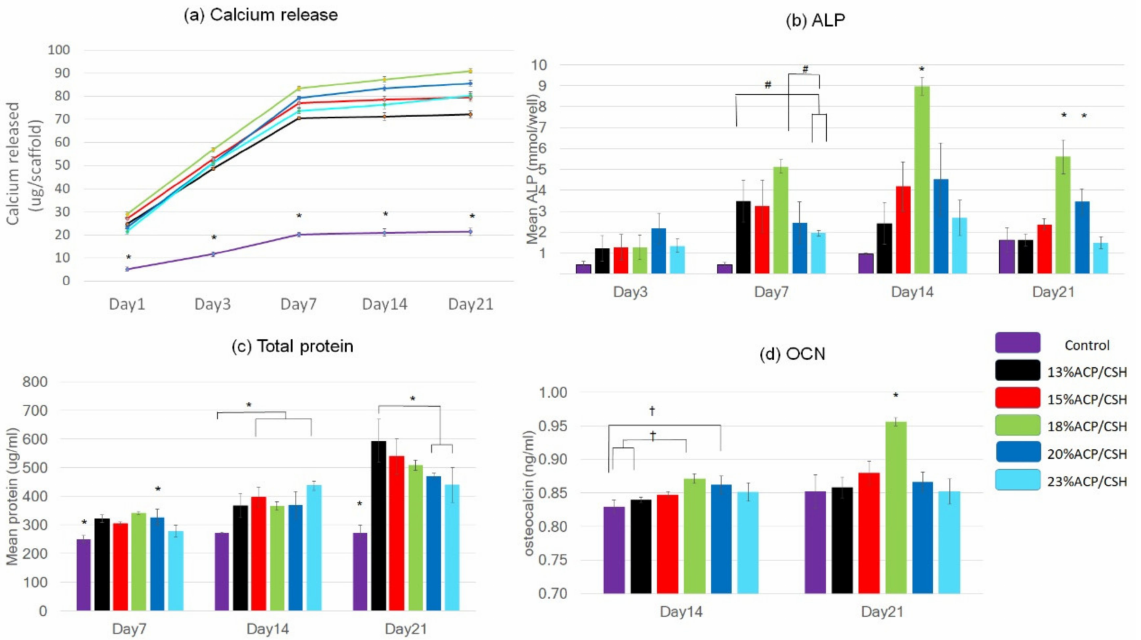
Figure 4. ( a ) Calcium release of the scaffolds soaked in PBS on days 1, 3, 7, 14, and 21. ( b ) ALP activity on days 3, 7, 14, and 21. ( c ) Total protein synthesis on days 7, 14, and 21. ( d ) Osteocalcin expression on days 14 and 21 ( † p < 0.05, # p < 0.01, * p <